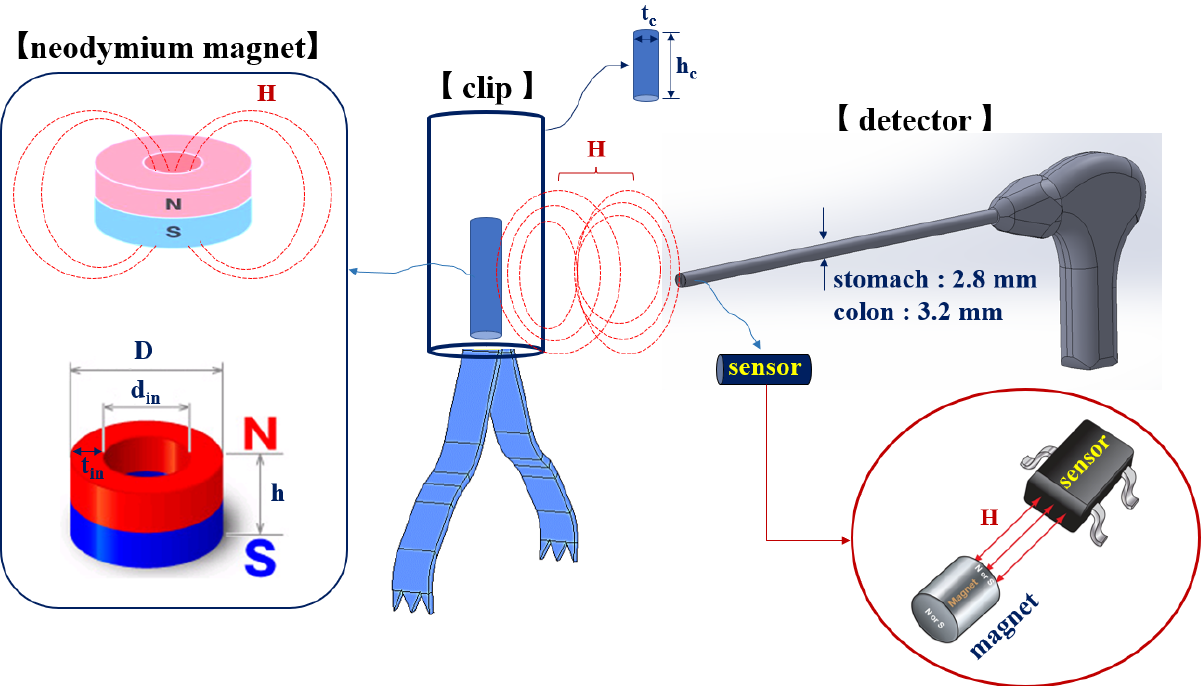
where the B and µ 0 are magnetic flux density and permeability of free space (4 π × 10 − 7 H/m). Therefore, the energy ( H 1 and ω 1 ) generated from the magnet sensor passes through the mucous membrane of the colon (or stomach). After that, energy is transmitted (TX) to the neodymium magnet (NeFe35) present inside the clip as shown in Figure 3, where ω is angular frequency which is 2 π f and the f is frequency. angular frequency which is 2 π f and the f is frequency.